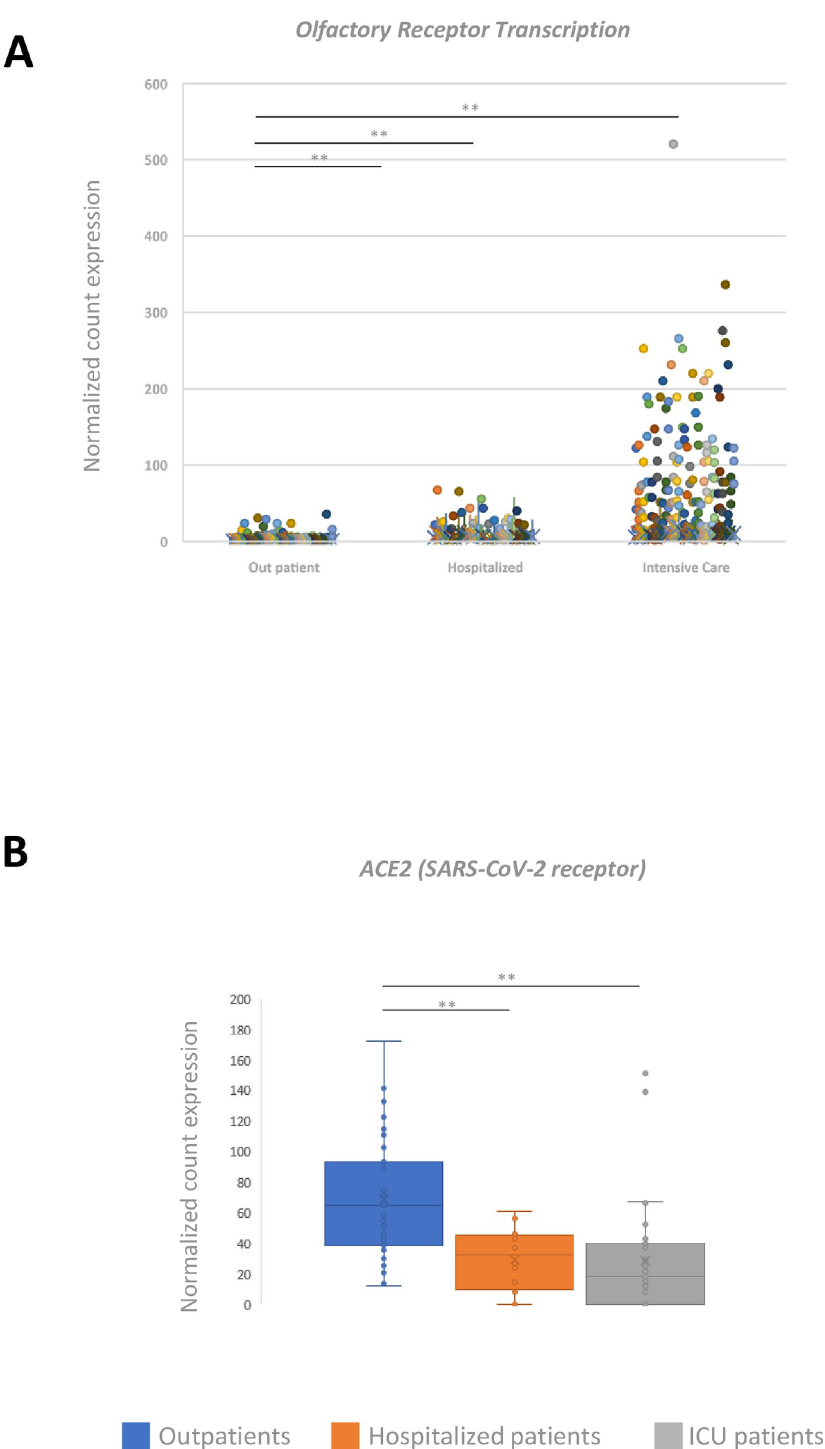
Fig 5. Transcriptomic analyses of olfactory receptors and the ACE2 SARS-CoV-2 receptor. (A) Individual expression of olfactory receptors in the three groups of patients. Each colored circle represents a distinct olfactory receptor differentially transcribed across the three groups (including OR10A7, OR10C1, OR10Q1, OR10V1, OR11A1, OR11H1, OR11L1, OR12D2, OR14K1, OR1I1, OR1J2, OR1L8, OR1M1, OR1Q1, OR2AE1, OR2AT4, OR2B11, OR2F1, OR2G6, OR2T10, OR2V1, OR2W3, OR4D1, OR4K1, OR4M1, OR4Q3, OR51T1, OR52L1,